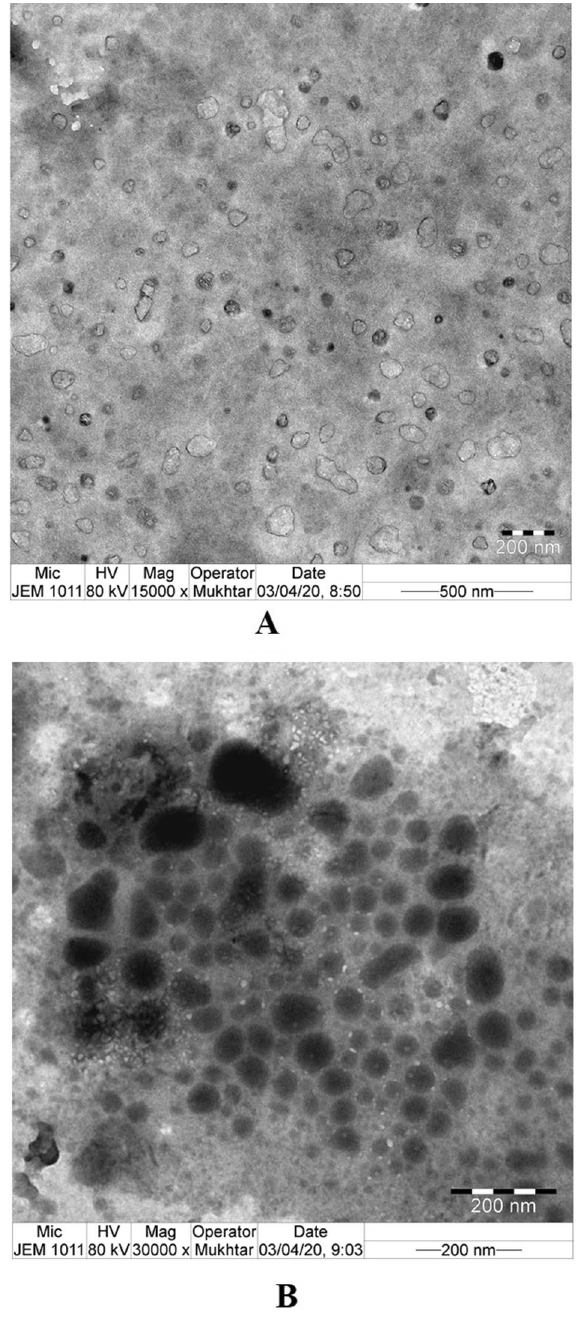
Figure 5. Transmission electron micrograph of dextran sulfate sodium (DSS) of batch 3 nanoparticles. ( A ) DSS nanoparticle at × 15,000 magnification. ( B ) DSS nanoparticles at × 30,000